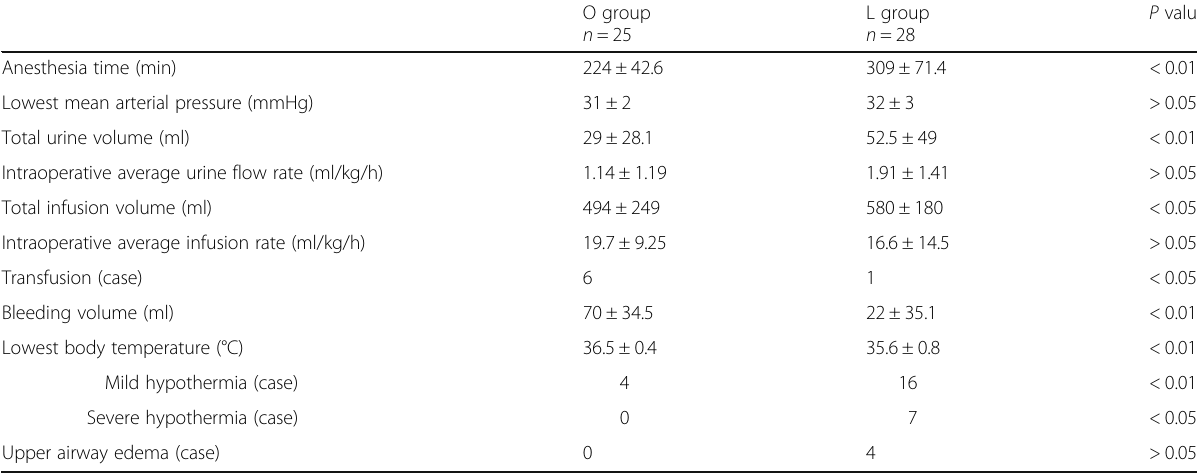
Table 2 Intraoperative patient data